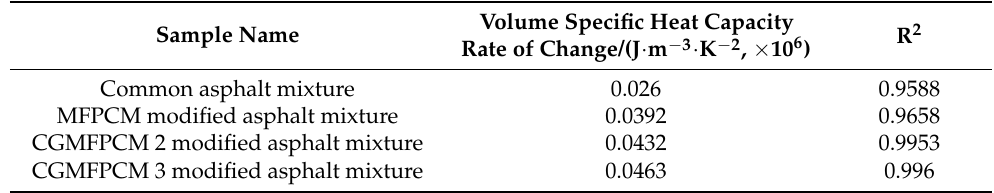
Table 17. Volume specific heat capacity Rate of change of common and modified asphalt mixtures.